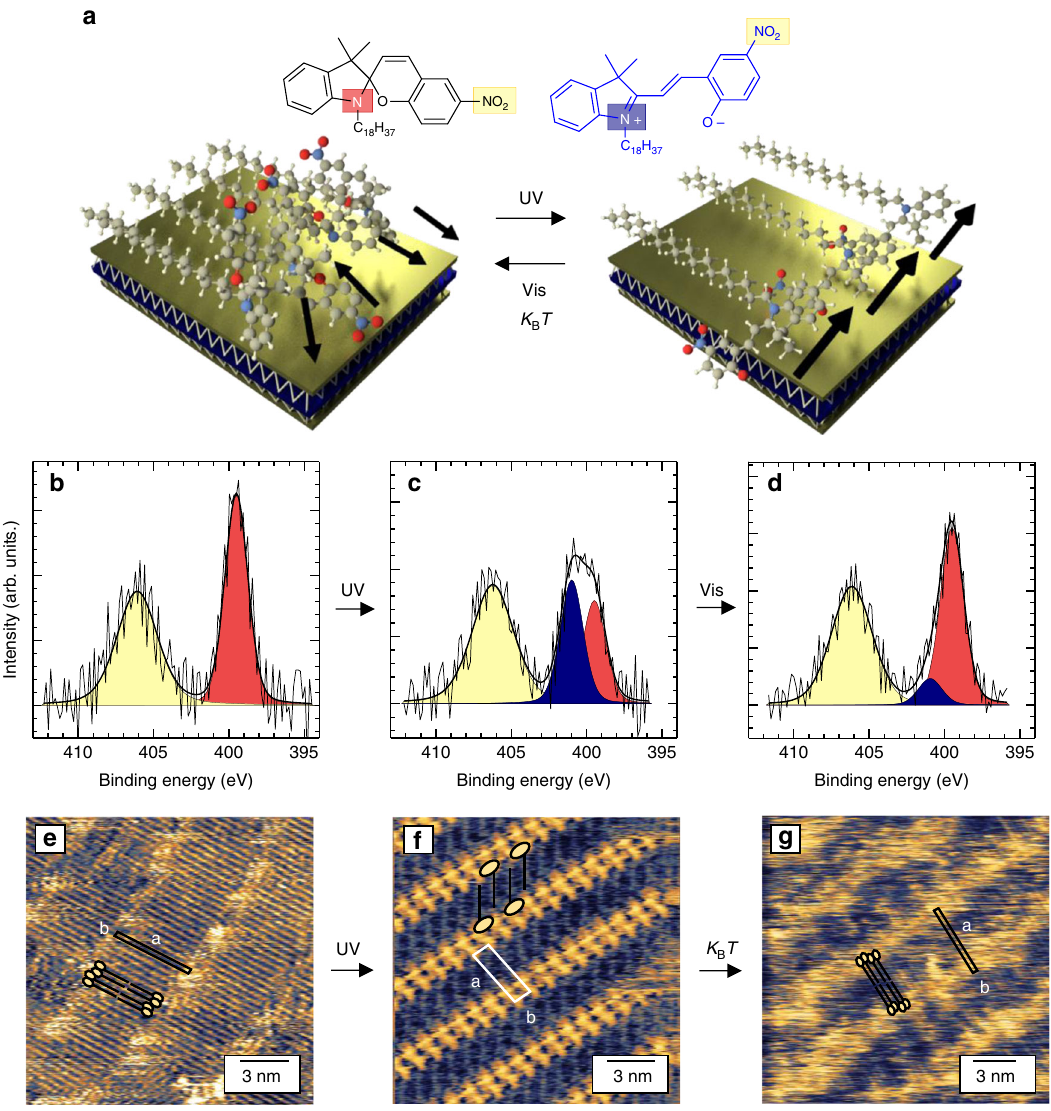
Fig. 1 Photo-switchable molecular crystals in two dimensions. a Schematic representation of our approach. A spiropyran (SP) derivative forms ordered crystalline structures when deposited on different van der Waals substrates. In the cartoon, a MoS 2 single layer is depicted in which the yellow (blue) layer represents the S-(Mo-) atomic plane. Photo-induced isomerization induces a structural rearrangement. The molecular dipoles (depicted as black arrows) are randomly oriented before irradiation, yet well aligned after UV irradiation, leading to a modi fi cation in the energetics of the van der Waals substrate. The chemical structure of the spiropyran (SP) – merocyanine (MC) derivative used in the study is also shown. b – d N 1s core-level spectra measured on the same spin-coated ultrathin fi lm on highly oriented pyrolytic graphite (HOPG) ( b ) kept in dark, ( c ) after in situ UV irradiation, and ( d ) after subsequent irradiation with green light. Each spectrum is characterized by multiple peaks fi tted by different components, corresponding to the different N hybridization. The colors of the fi tting components recall those of the N atoms in ( a ). e – g Scanning tunneling microscopic imaging of SP assemblies on HOPG. Height images of the molecular assemblies obtained ( e ) after spin-coating the SP solution, ( f ) immediately after UV irradiation, and ( g ) 48 h after UV irradiation. A schematic sketch of the molecule is superimposed to the images to facilitate the visualization of the molecular ordering. Tunneling parameters: I t = 20 pA ( e , f , g ), V t = 1000 mV ( e , g ), 600 mV ( f